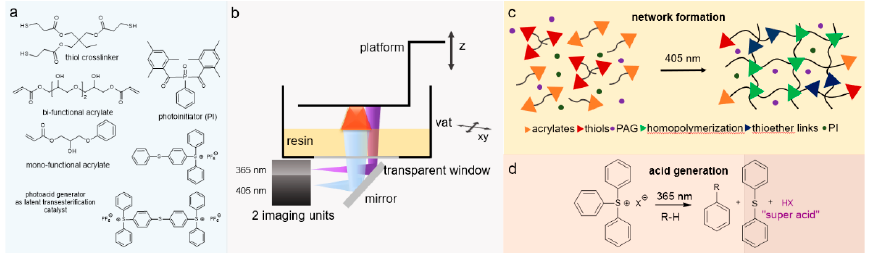
Figure 34. ( a ) Constituents of the resin formulation for selectively activating a transesterification catalyst in thiol-acrylate photopolymers; ( b ) dual-light wavelength DLP 3D printer setup; ( c ) visible light-mediated network formation during DLP 3D printing; ( d ) UV light-triggered activation of Brønsted acids acting as a transesterification catalyst. Reproduced from Ref. [237] with permission from the Royal Society of Chemistry.